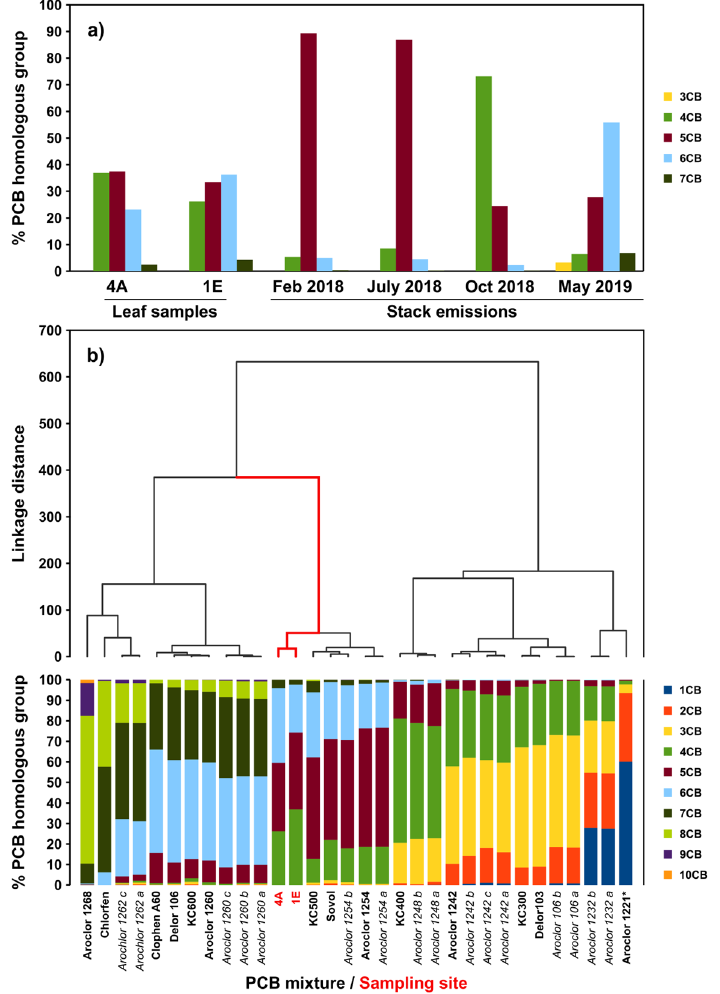
Figure 5. Percentage of the PCB homologous group (3CB ‐ 7CB) in leaf samples from sites 4A and 1E and in the stack emission of the cement plant in four periods (data from [37]) ( a ); the results of the hierarchical clustering ( b ) carried out on the percentage of the PCB homologous groups (1CB ‐ 10CB) calculated for the same leaf samples and selected PCBs mixtures commercialized in the past. The lower histogram represents the percentage of the PCB homologous groups (1CB ‐ 10CB) (data form [43] (labels in italics) and [42]).